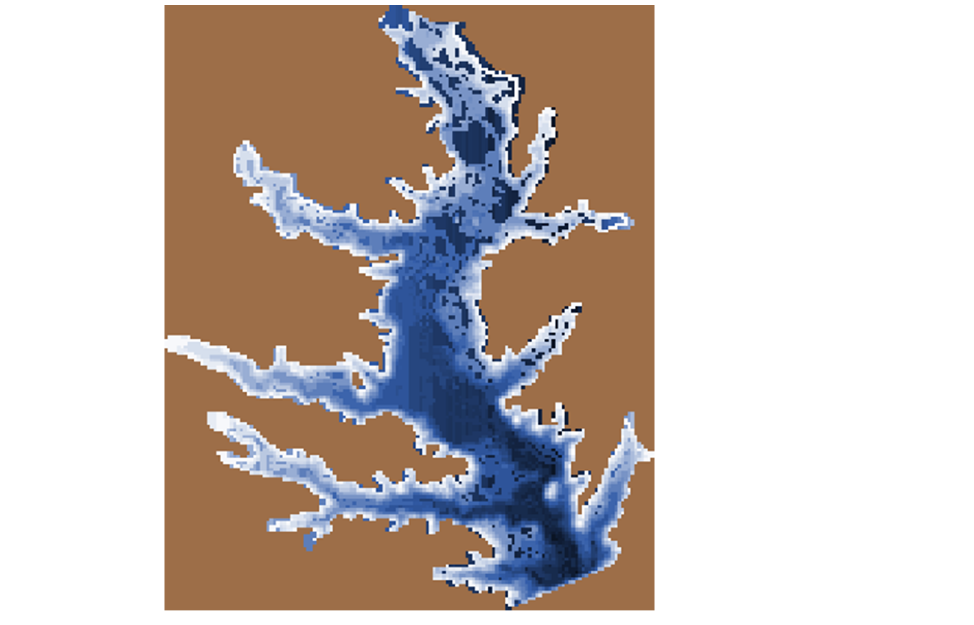
Figure 2. Representation of Lake Conroe in the model within a 148 × 183 lattice of 27,084, 1-ha habitat patches. Table 1. Equations used in the model to calculate daily rates of growth and senescence of Hydrilla ,